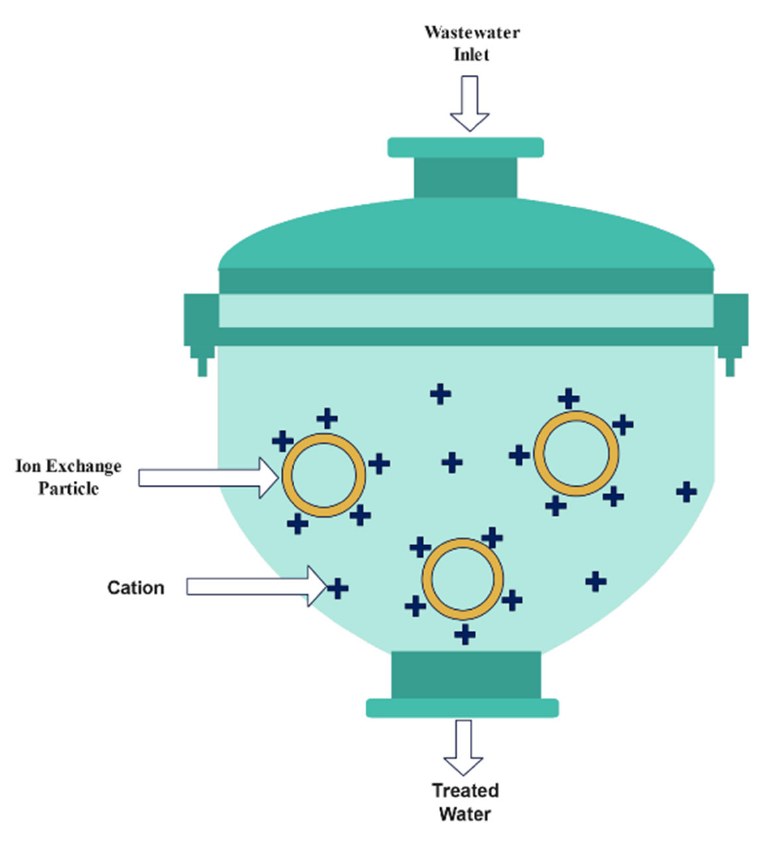
Figure 2. Ion exchange technique